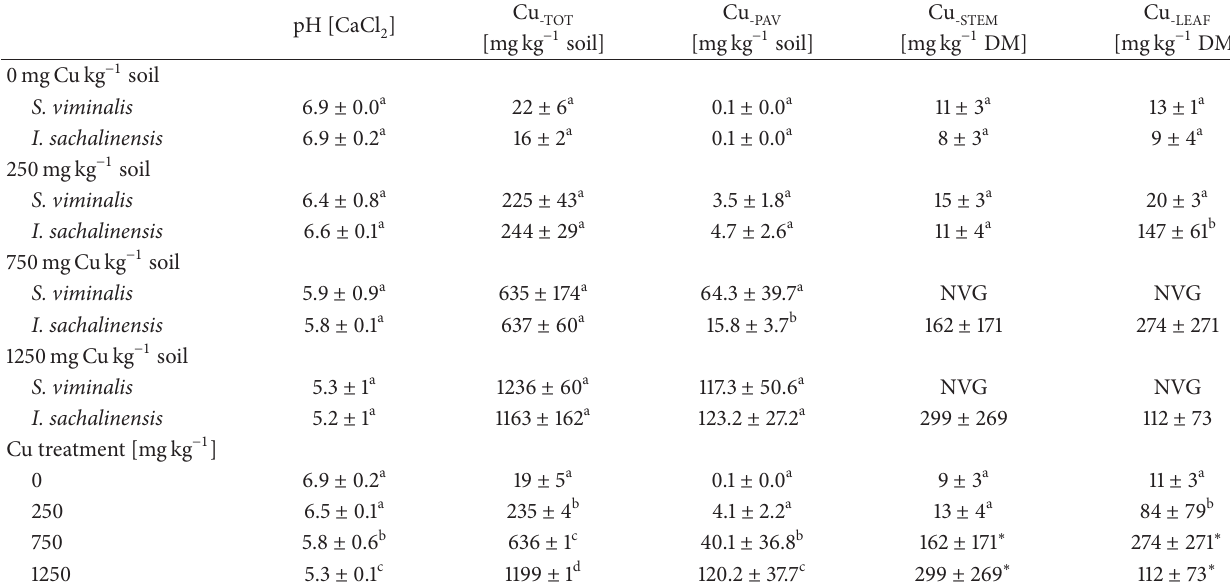
Table 2: Soil pH, total soil Cu (Cu viminalis and I. sachalinensis grown on agricultural soils treated with different levels of Cu